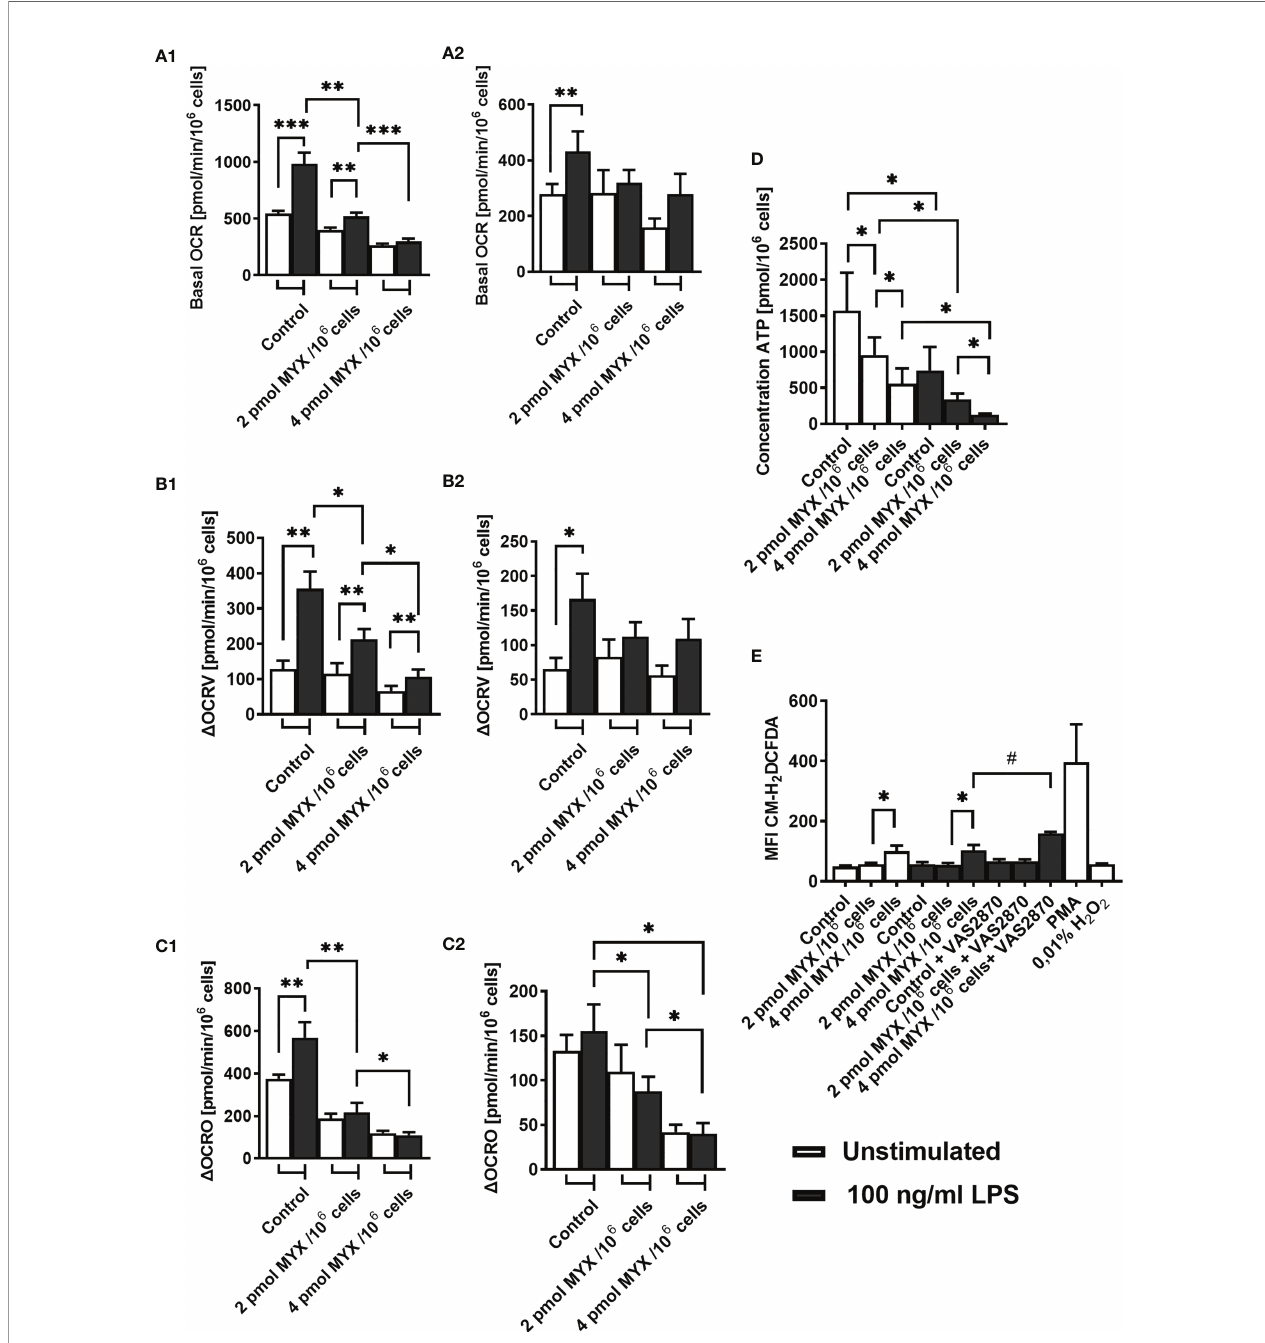
FIGURE 2 | Metabolic restriction with MYX alters ROS and ATP production in human monocytes in the absence of glucose. (A – C) Oxygen consumption rate (OCR) and inhibitor sensitive oxygen consumption rate ( D OCR) of quiescent and stimulated (100 ng/mL LPS) human monocytes after 2 h (A1-C1) 6 h (A2-C2) of incubation in the presence or absence of Myxothiazol (MYX) (pmol/10 6 cells) or 1% (v/v) DMSO (vehicle control) under glucose free conditions. After preincubation, (A) basal OCR, (B) VAS2870 sensitive OCR ( D OCRV) and (C) oligomycin sensitive OCR ( D OCRO) were assessed (mean ± SEM; n = 9 – 10). (D) Intracellular ATP content of quiescent and stimulated (100 ng/mL LPS) human monocytes after 3 h of incubation in the presence or absence of MYX (pmol/10 6 cells) or 1% (v/v) DMSO (vehicle control) under glucose free conditions was measured by bioluminescence (mean ± SEM; n = 6). (E) Median fl uorescence intensity of quiescent and stimulated (100 ng/mL LPS) human monocytes after 2 h of incubation in the presence or absence of MYX (pmol/10 6 cells) or 1% (v/v) DMSO (vehicle control) and/or 50 µM VAS2870, or 100ng/ml PMA or H 2 O 2 under glucose free conditions, stained with CM-H 2 DCFDA (mean ± SEM; n = 3 – 5); *p < 0.05, **p < 0.01, ***p < 0.001. Wilcoxon signed rank test. # p < 0.05; Mann-Whitney U